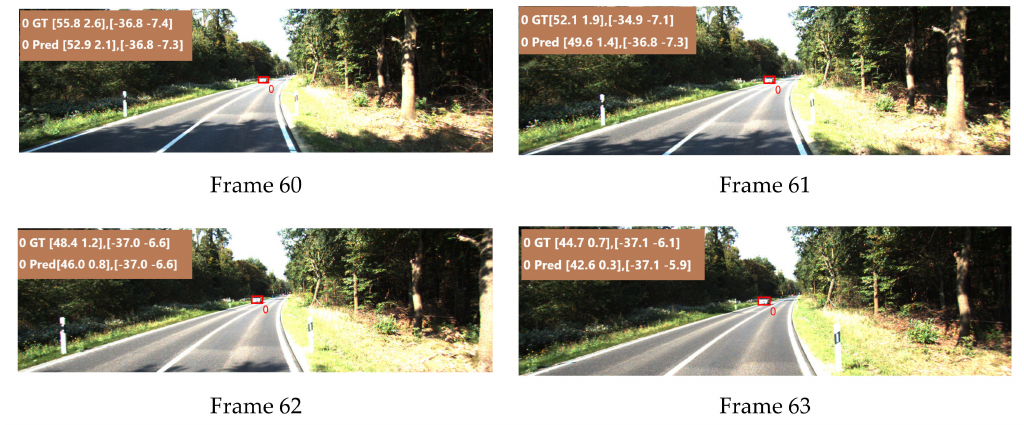
Figure 10. Prediction results of the target vehicle in the opposite direction traffic scenario. The green font represents the true values, which are the longitudinal lateral distance and longitudinal lateral velocity; the blue represents the predicted values, which are the longitudinal lateral distance and longitudinal lateral